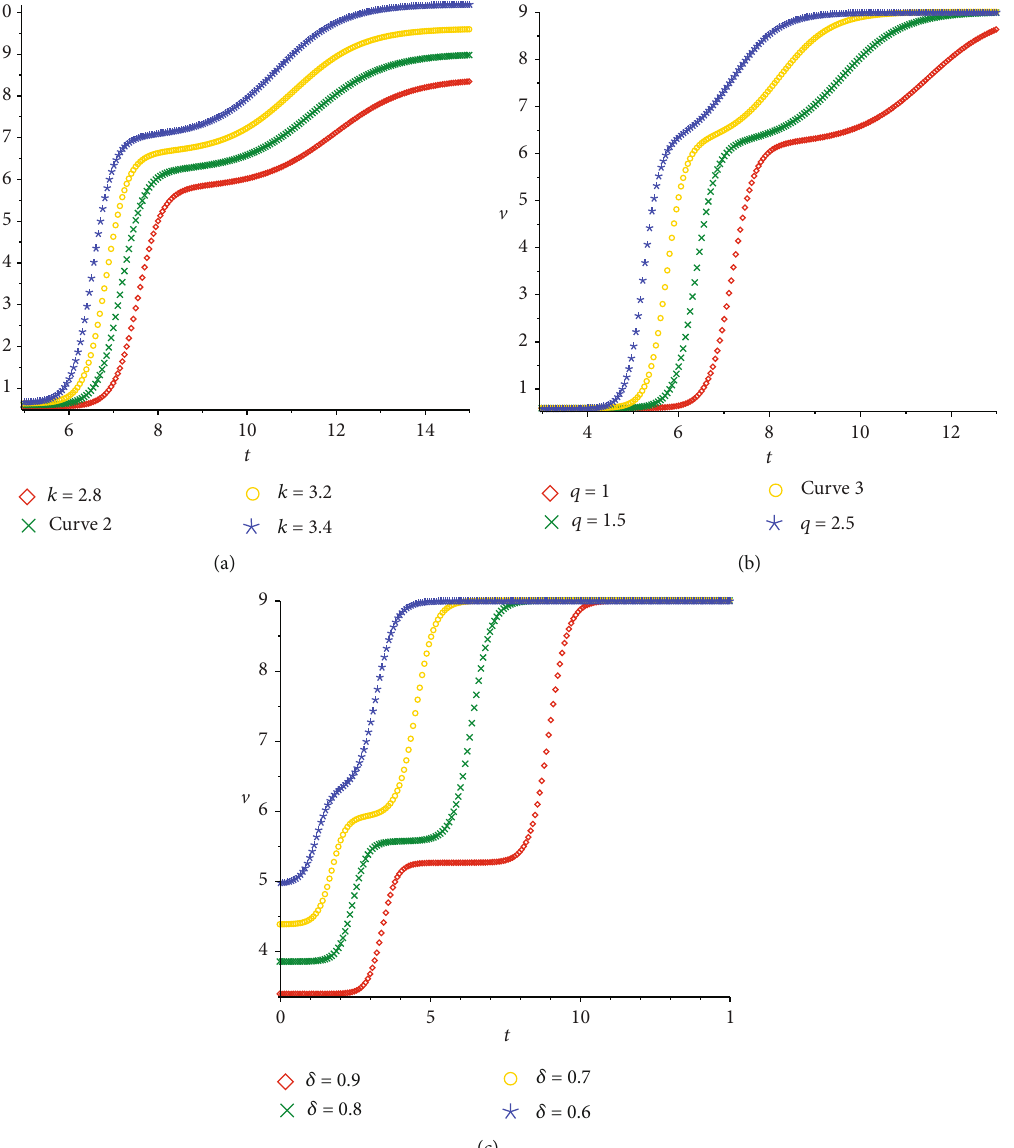
= 1, l = 0 : 5 : (a) q = 1, δ = 0 : 9 , (b) k = 3, δ = 0 : 9 K = 3 , q = 1 , and (c) q = 1, k = 3 at x = 40 1 2